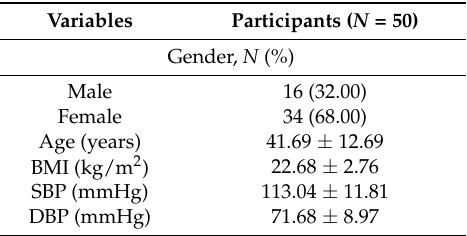
Table 2. Characteristics of white-collar